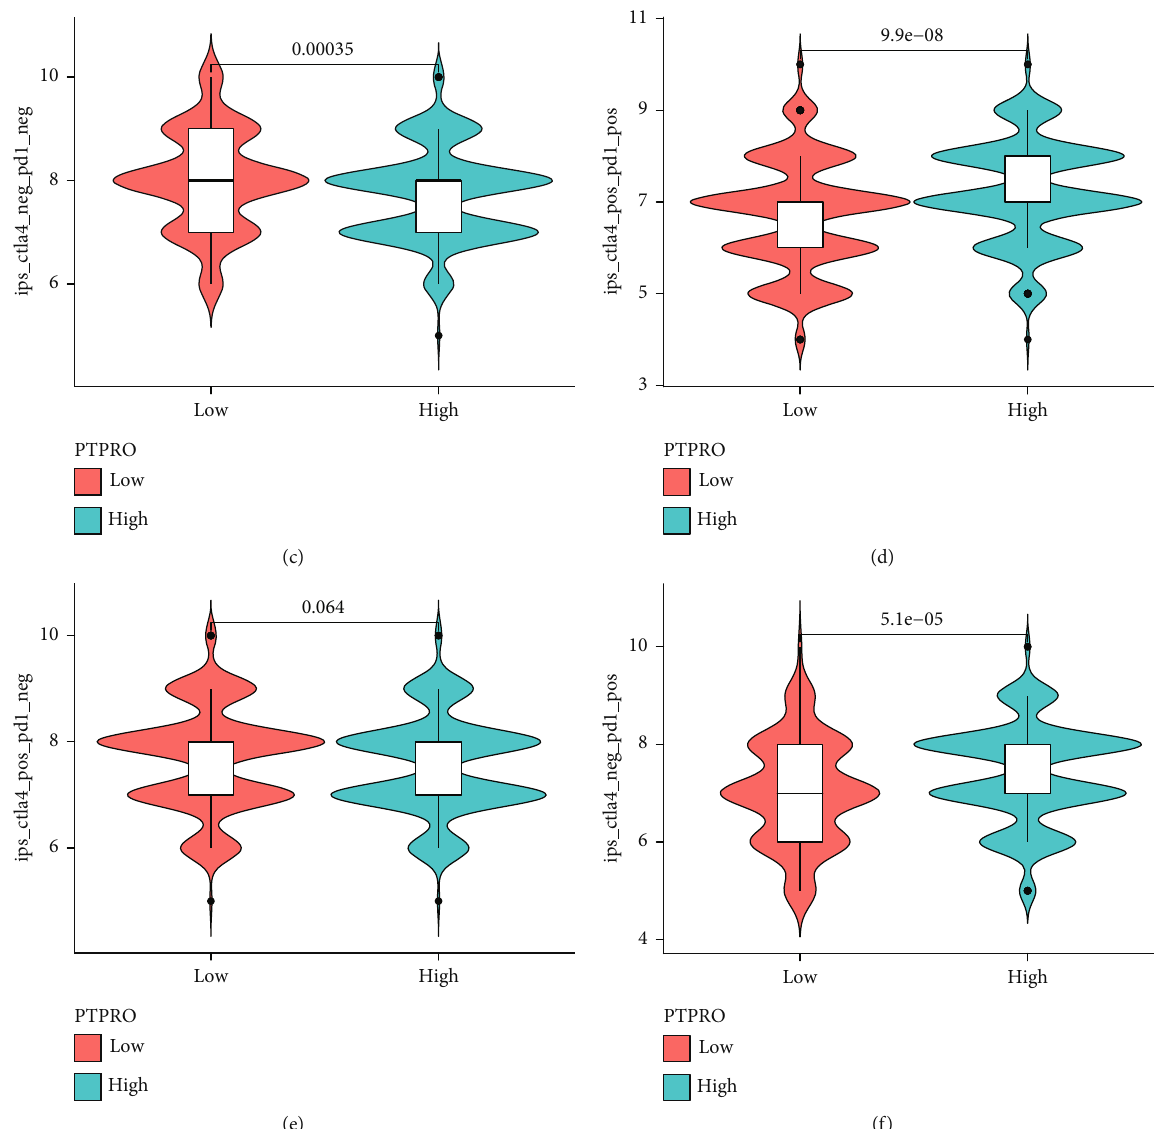
Figure 8: Prediction of sensitivity to immunotherapy based on PTPRO expression levels. (a) Correlation analysis of immune checkpoints and PTPRO expression level. (b) Immune, stromal, and ESTIMATE scores for high and low PTPRO expressions in LUAD. (c – f) The IPS scores between high and low expressions of the PTPRO groups when CTLA-4 or/and PD1